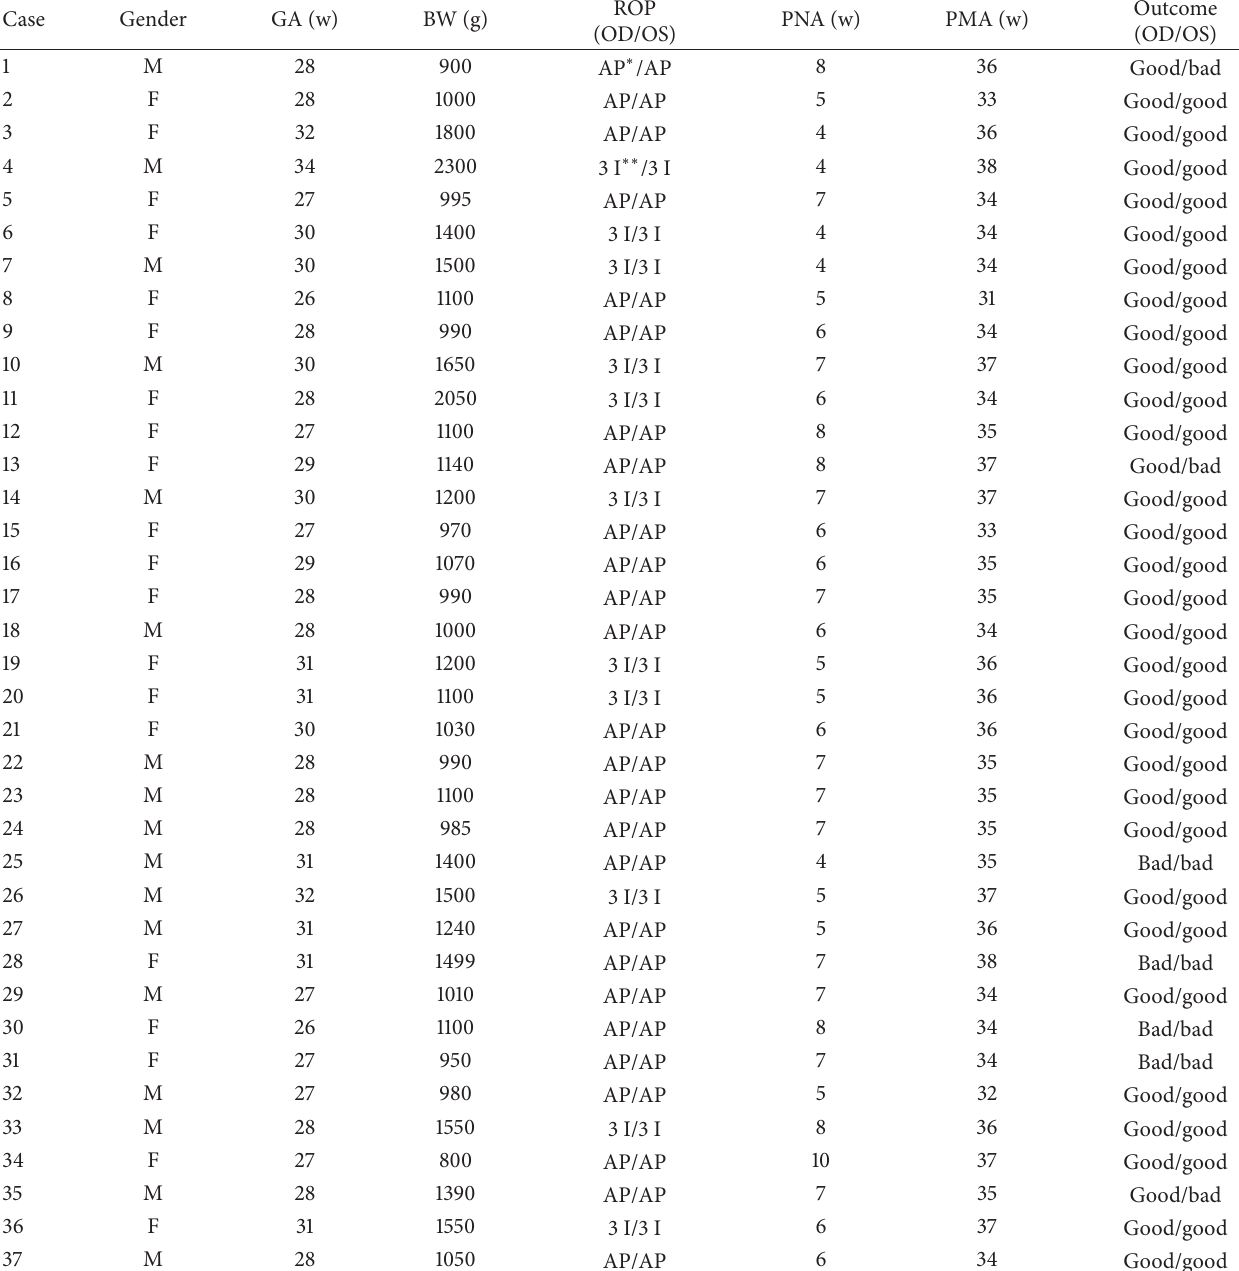
Table 3: Data of each premature infant treated by intravitreal injections of